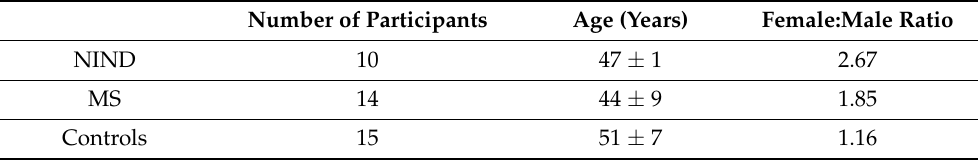
Table 1. Study participant demographic data ( TAAR1 expression in whole PBMC cohort).